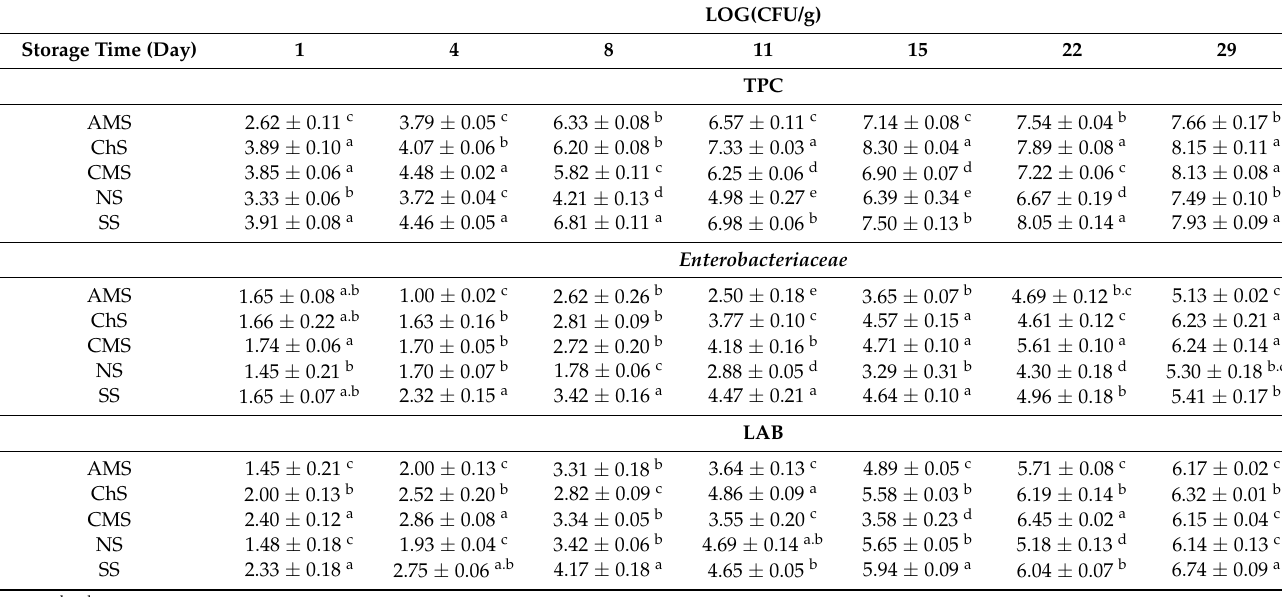
Table 1. Effect of Aronia melanocarpa, Chaenomeles superba and Cornus mas leaf extracts on microbial counts in pork sausages stored in MAP at 4 ◦ C (mean ±